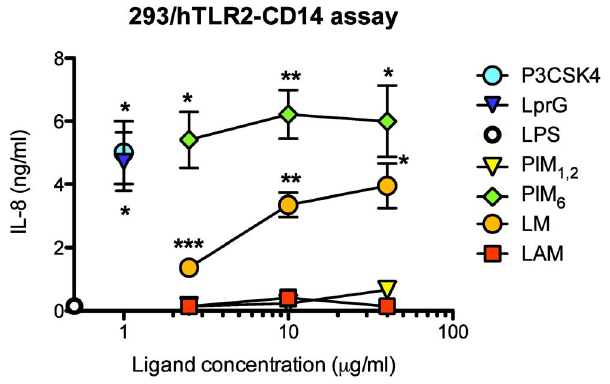
Figure 4. TLR2 agonistic activity of MTB cell wall associated glycolipids. 293-hTLR2-CD14 cells were cultured in 96-well round bottom plates (20,000 cells/well) for 16 h with TLR2 agonist P3CSK4, lipoprotein LprG, TLR4 agonist LPS or MTB glycolipids (PIM 1,2 , PIM 6 , LM, LAM) at indicated concentrations. IL-8 in culture supernatants was quantified by ELISA. Shown are means 6 SEM of three independent experiments. * p , 0.05, ** p , 0.01, *** p , 0.001.